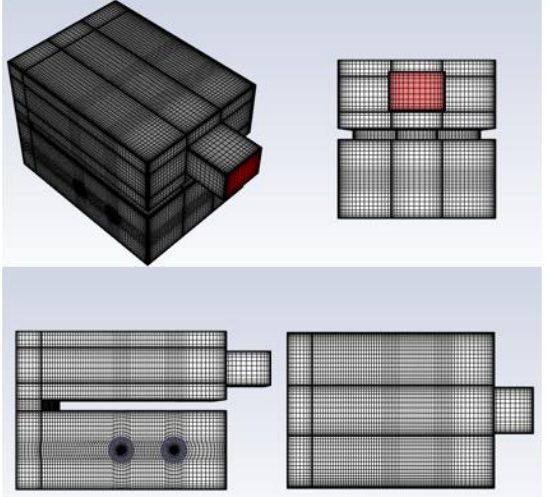
Figure 4. Incinerator mesh structure diagram.